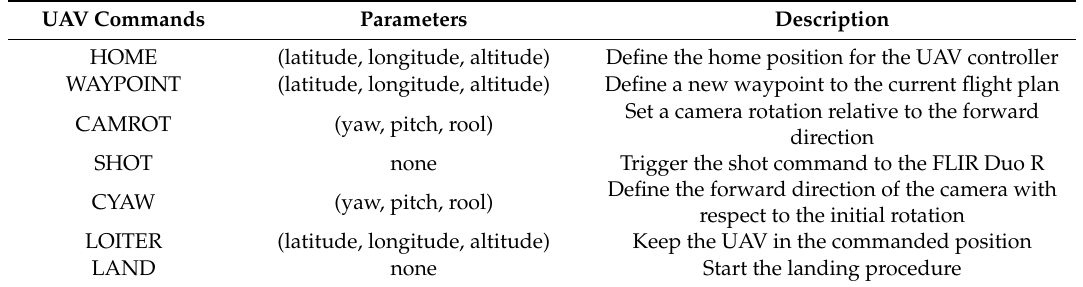
Table 3. Mission planning and Unmanned Aerial Vehicle (UAV) control command